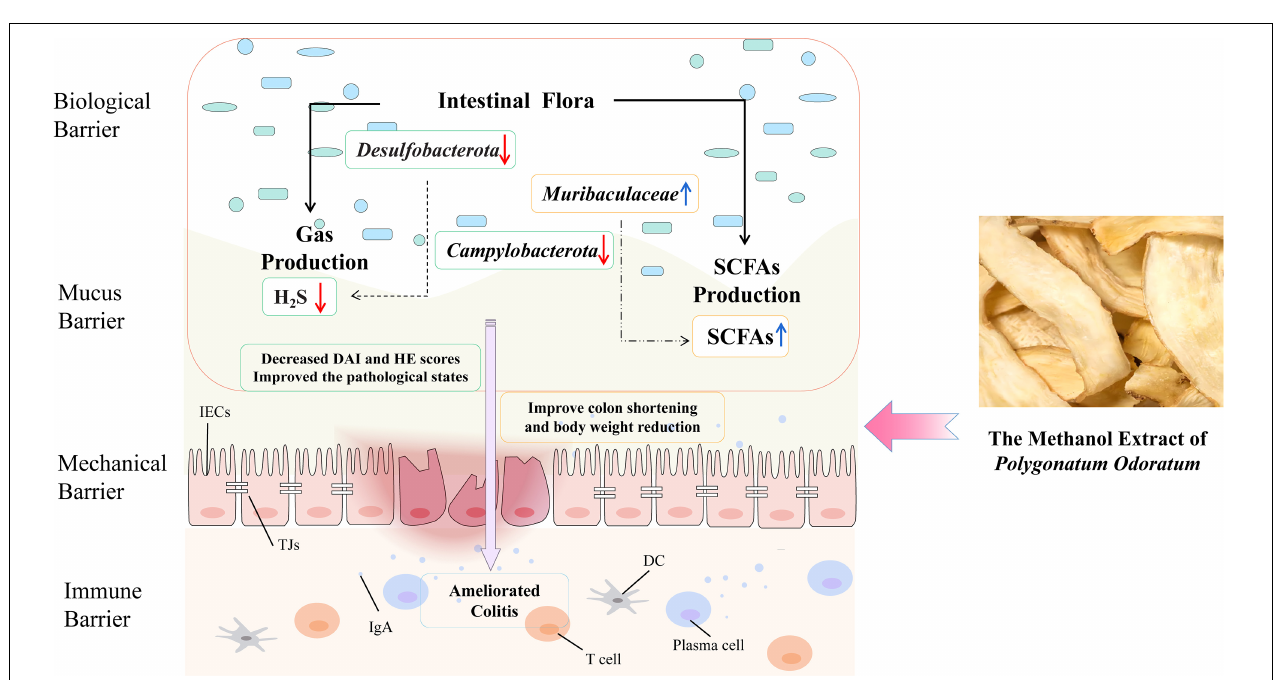
FIGURE 6 | LEfSe analysis and correlation analysis. (A) LEfSe analysis. (B) LDA scores (LDA) > 4, p < 0.05. (C) Heatmap of Pearson correlation analysis, Red-white-blue color: positive correlation-no correlation-negative correlation. ** p < 0.01, * p < 0.05.